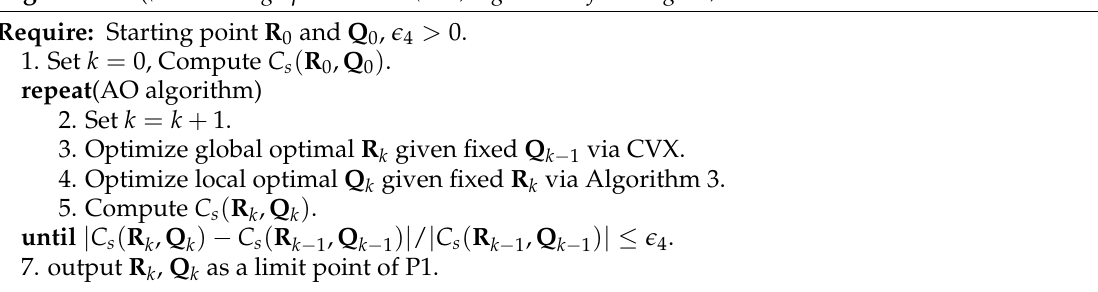
Algorithm 4 ( (Alternating optimization (AO) algorithm of solving